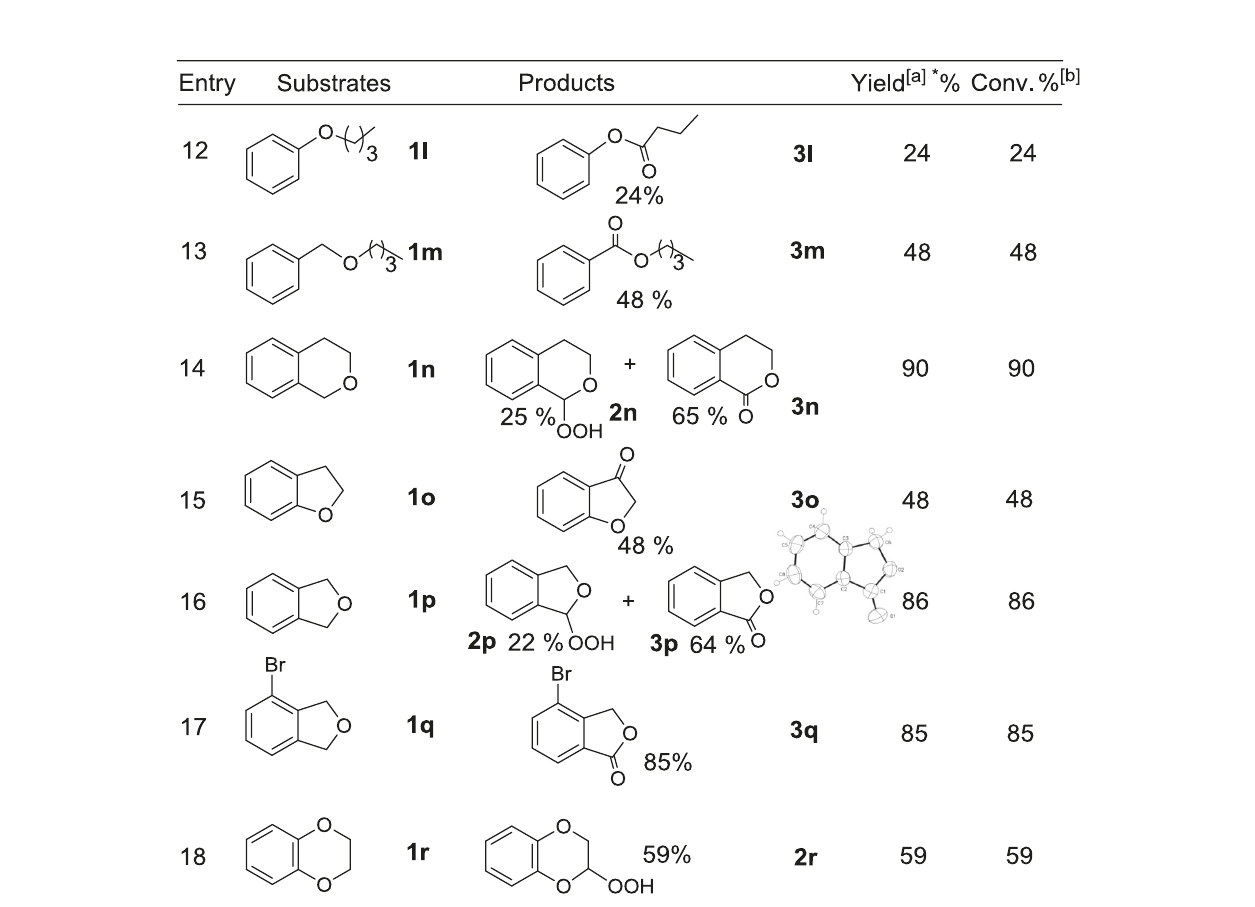
Table 2 Substrate scope of aromatic ring containing